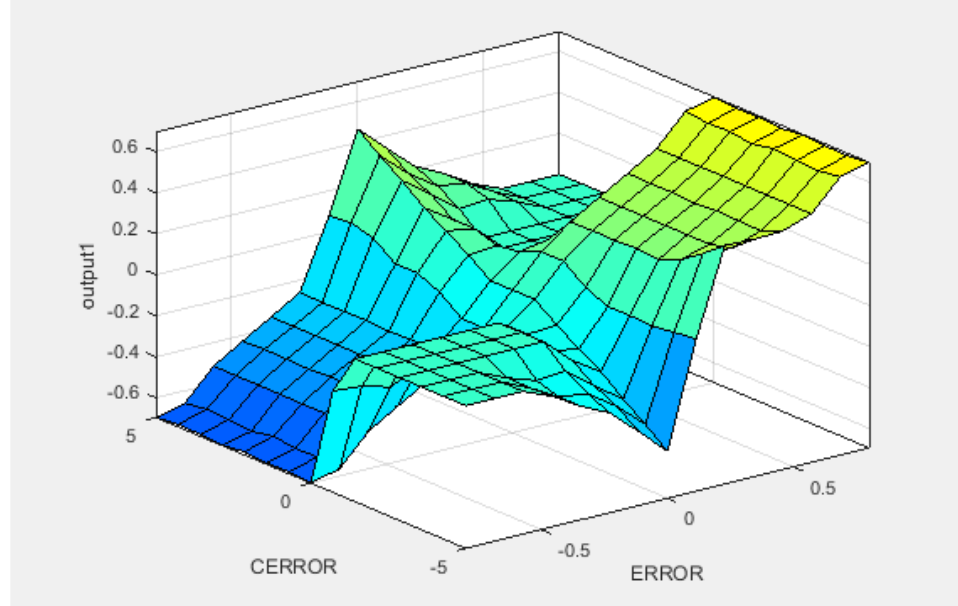
Figure 20. Fuzzy system behavior for output/input regulator mode.